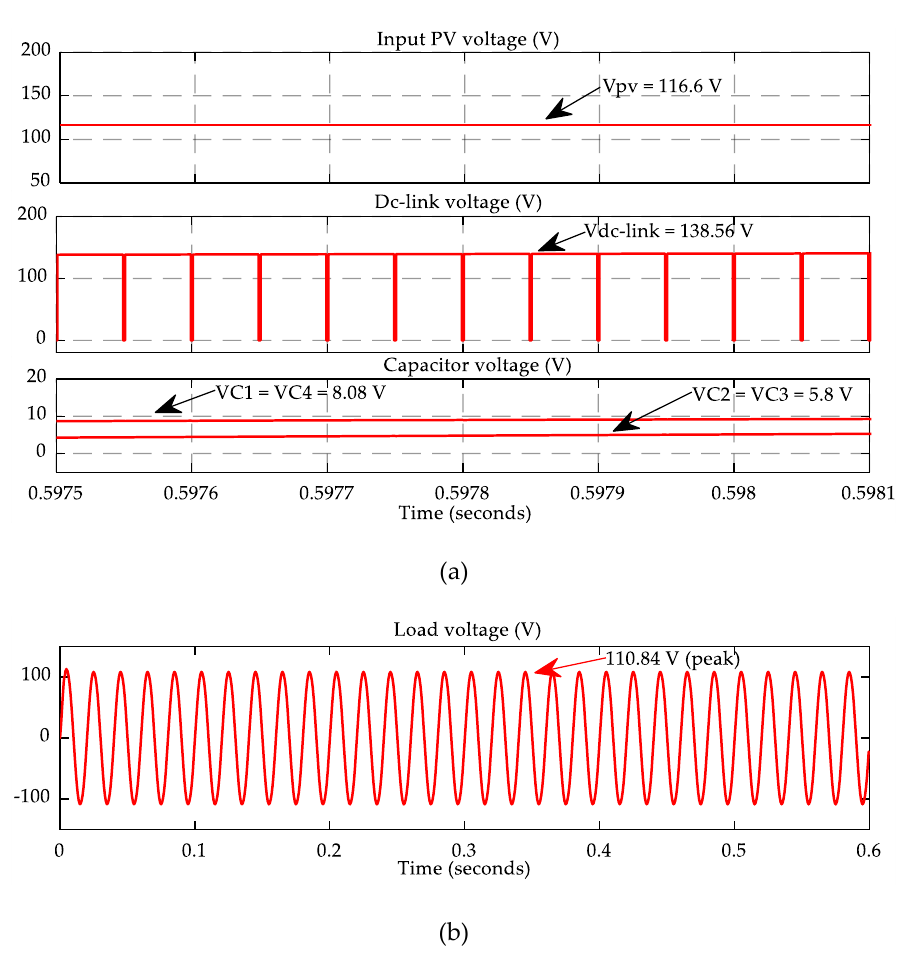
Figure 7. Simulation results during shoot-through state: ( a ) output voltage of the PV unit, DC-link voltage, and capacitor voltages, and ( b ) output load voltage.